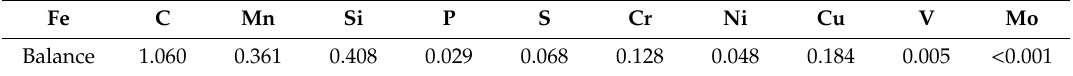
Table 1. Chemical composition of the investigated wires (wt